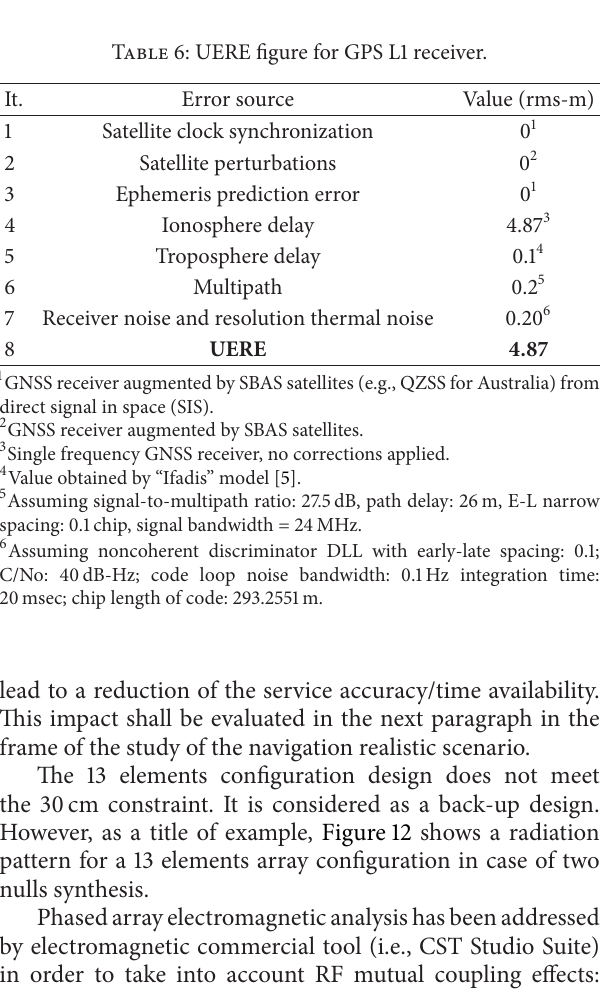
Figure 15: Ground planar array antenna. FRPA simulated and “cosine-like” pattern.